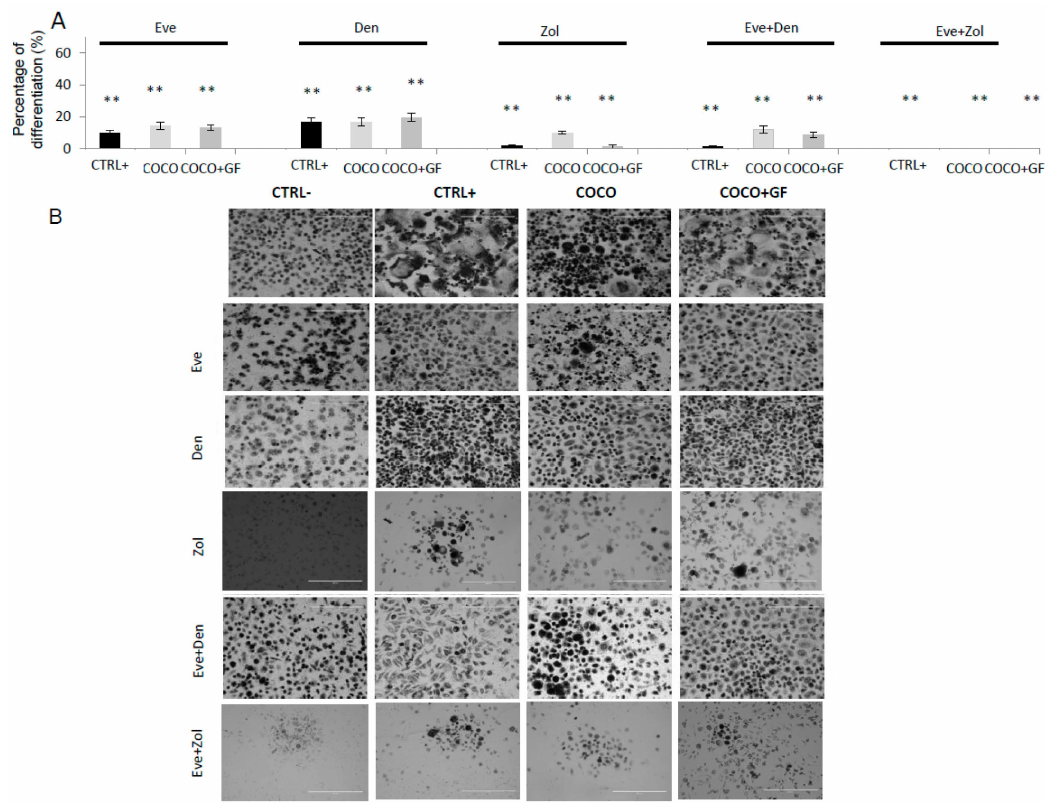
Figure 4. Eve treatment on osteoclastogenesis induced by SCP2 as a single agent and in combination: Drug effect on osteoclastogenesis Eve was used at a concentration of 0.1 µ g/mL. ( A ) Percentage of differentiation with respect to untreated samples after Eve and other bone-targeted drugs administration; Anova analysis and Bonferroni Test were performed when appropriate; for all conditions (CTRL+, COCO; COCO + GF) a significant decrease in OC cell-like cells was observed in treated samples with respect to those untreated (** p < 0.00001); ( B ) Pictures of all experimental conditions performed at 10 ×